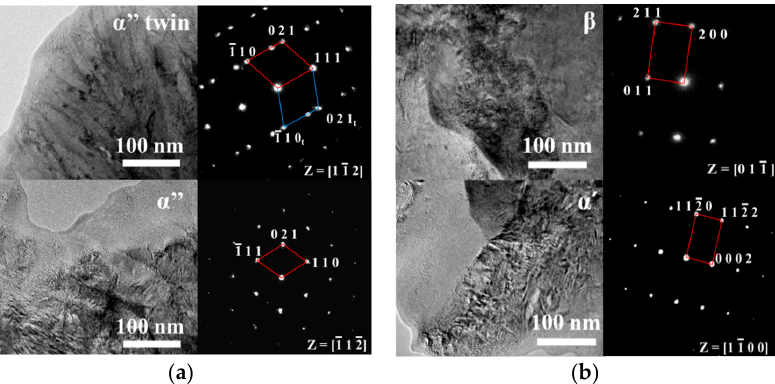
Figure 9. TEM bright field images of the microstructure of Ti-25Ta samples with selected area diffraction patterns. ( a )sample S1 (v = 120 mm/s, E = 694 J/mm 3 ) and ( b ) sample S3 (v = 1100 mm/s, E = 76 J/mm 3 ).